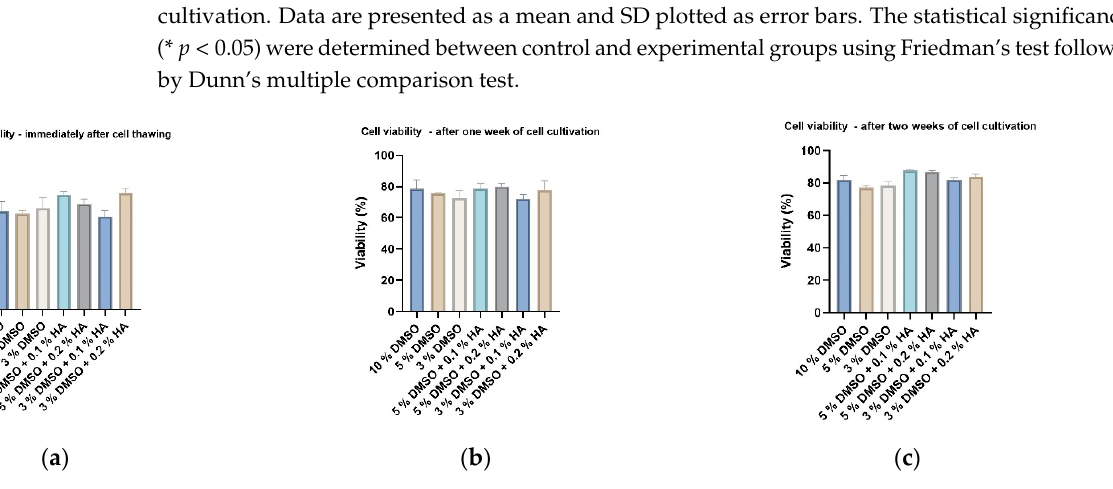
Figure 13. Viability of ADSCs measured using pulse area analysis and electronic current exclusion/pulse-field analysis on CaSy cell counter (OMNI Life Science GmbH): ( a ) immediately after thawing; ( b ) after one week of cell cultivation; ( c ) after two weeks of cell cultivation. Data are presented as a mean and SD plotted as error bars. The statistical analysis was performed between control and experimental groups using Friedman’s test followed by Dunn’s multiple comparison test.